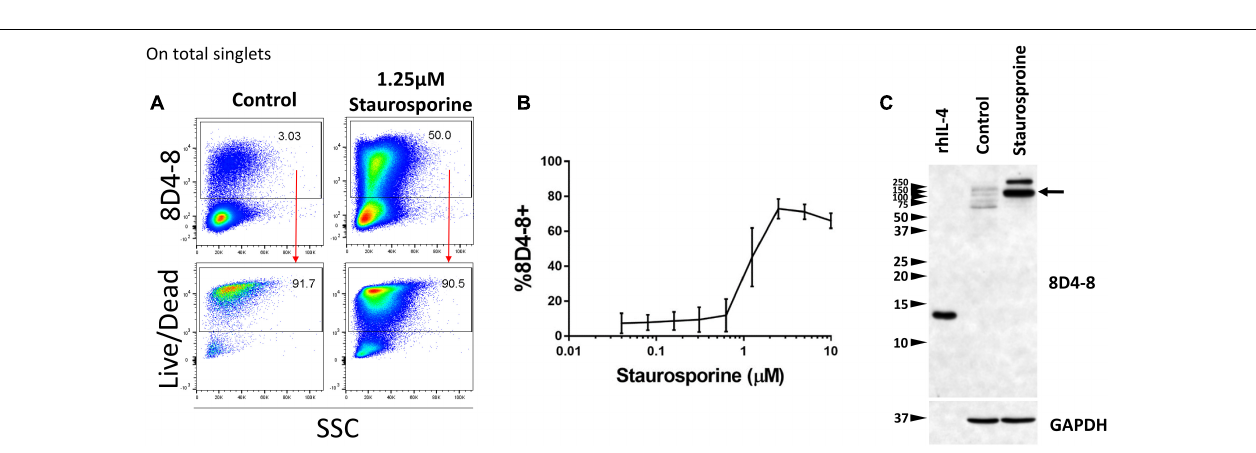
FIGURE 4 | Staurosporine treatment increases the expression of the 8D4-8 target. PBL were pregated to remove doublets (not shown). (A) Representative scatter plots showing control and 1.25 µ M staurosporine-treated PBL. Staurosporine-treated PBL show increased expression of the 8D4-8 target, and, just like in control, these cells are mostly Live/Dead + . (B) Increasing concentrations of staurosporine induce the expression of the 8D4-8 target. In the graph, points are averages and error bars represent standard deviation. For (A,B) data are representative of 3 experiments from 3 donors. (C) Western blotting of recombinant human IL-4 (rhIL-4), control, and staurosporine-treated cell lysates demonstrate that the protein(s) upregulated by staurosporine treatment is of high molecular weight, with a major band around 100 kD (black arrow). Western blot data are representative of 4 stimulations and experiments from 4